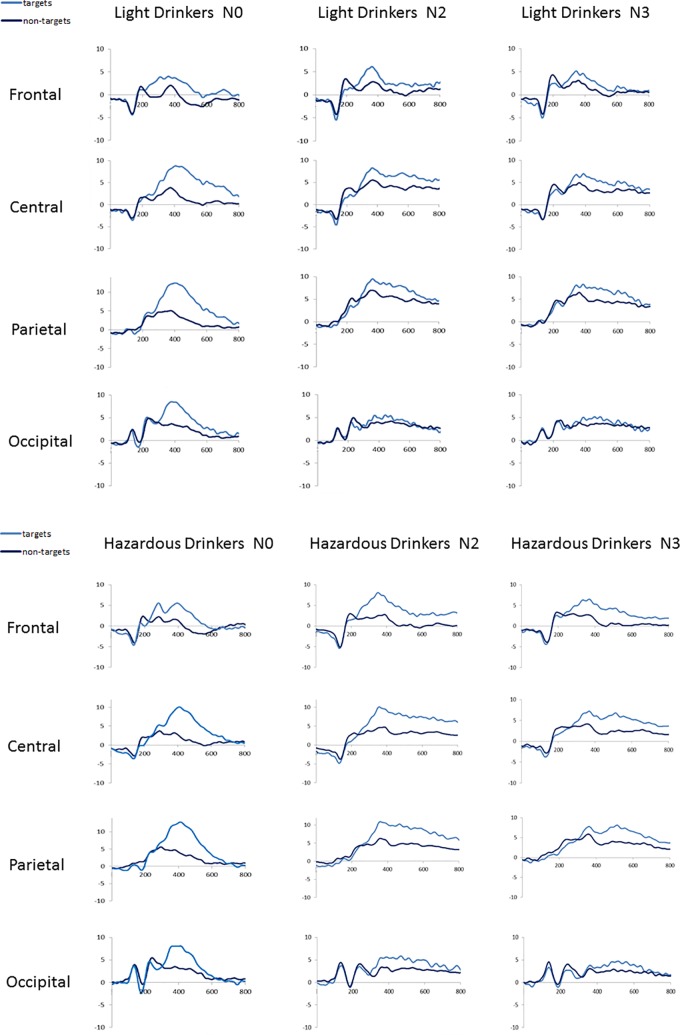
Waveforms recorded at frontal (mean amplitudes for F3, Fz, F4), central (C3, Cz, C4), parietal (P3, Pz, P4), and occipital (O1, Oz, O2) sites for the light (n = 24) and the hazardous (n = 25) drinkers on each condition (N0, N2, N3) for target and nontarget trials.